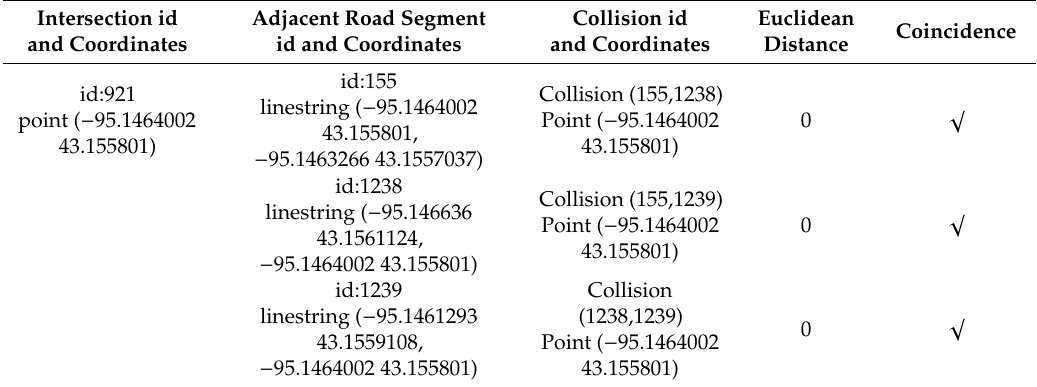
Table 2. The evaluation results of the intersection extraction algorithm.